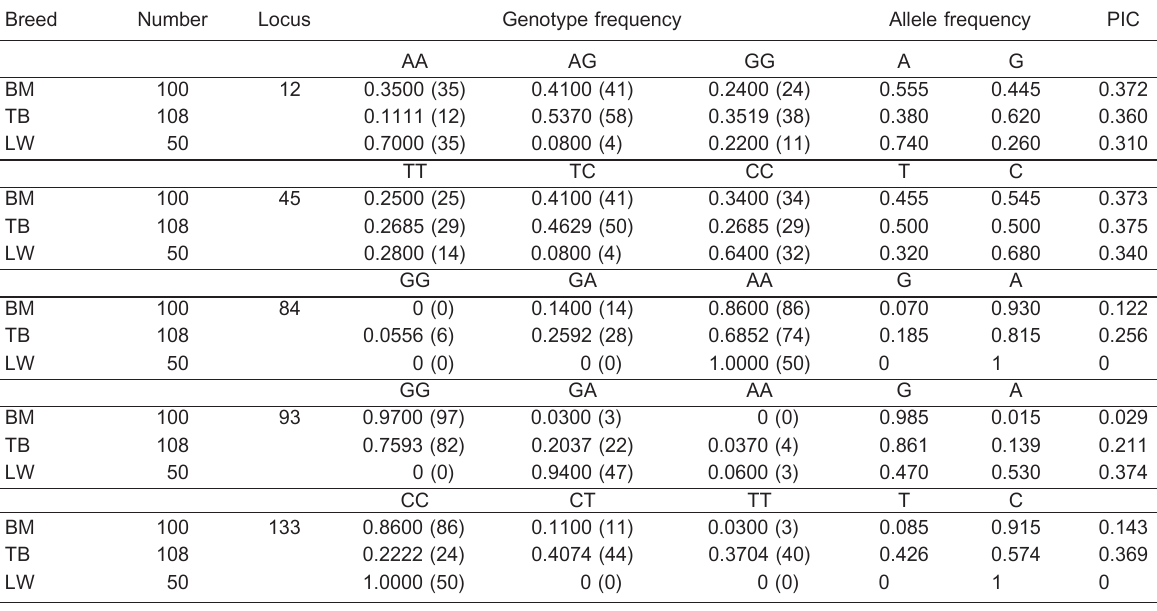
Table 1. Genotype and allele frequency of GH gene in three pig breeds. Breed